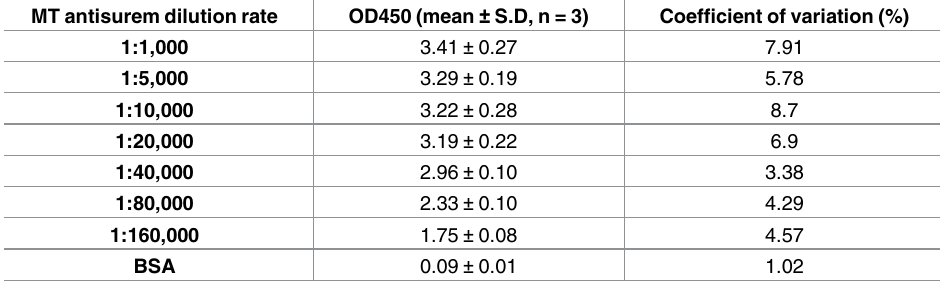
Values within a column having different superscript letters are significantly different and values within a line with “ * ” are significantly different ( p < 0.05). N means sample number.